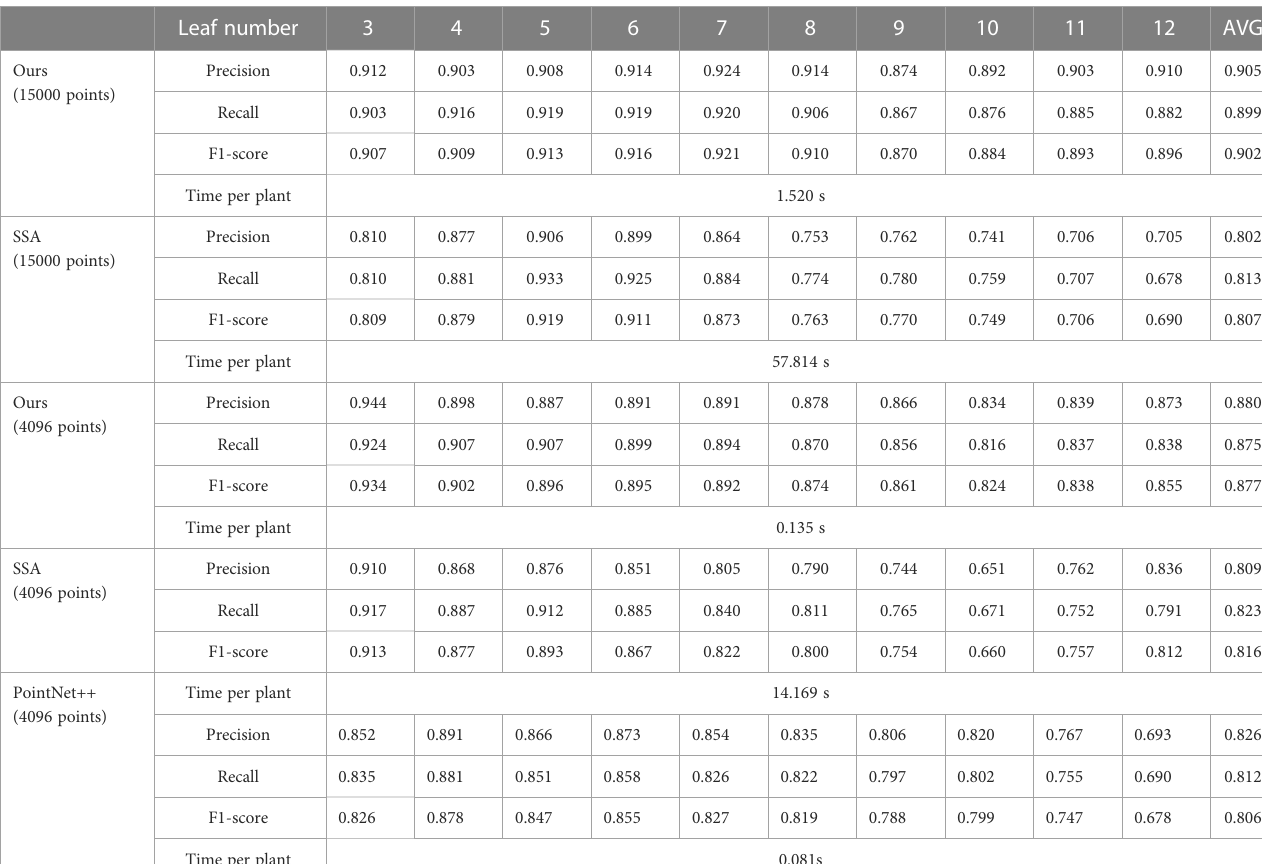
TABLE 3 The numerical accuracy evaluation results of plant point clouds with different leaf